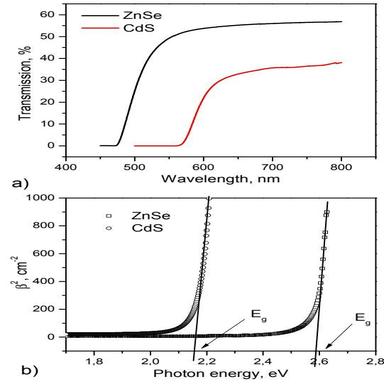
The transmission (a) and the square of the absorption coefficient (b) spectra of ZnSe and CdS crystals as the function of the wavelength and photon energy, respectively.